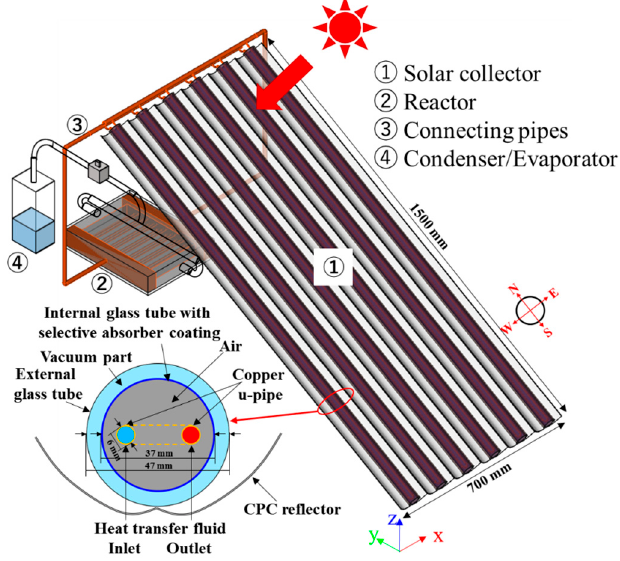
Figure 1. A schematic diagram of the SCHP